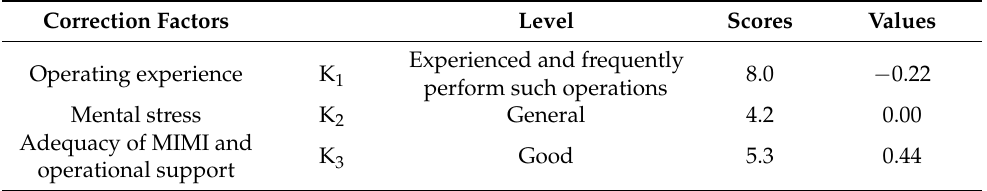
Table 10. Questionnaire summary of HCR correction